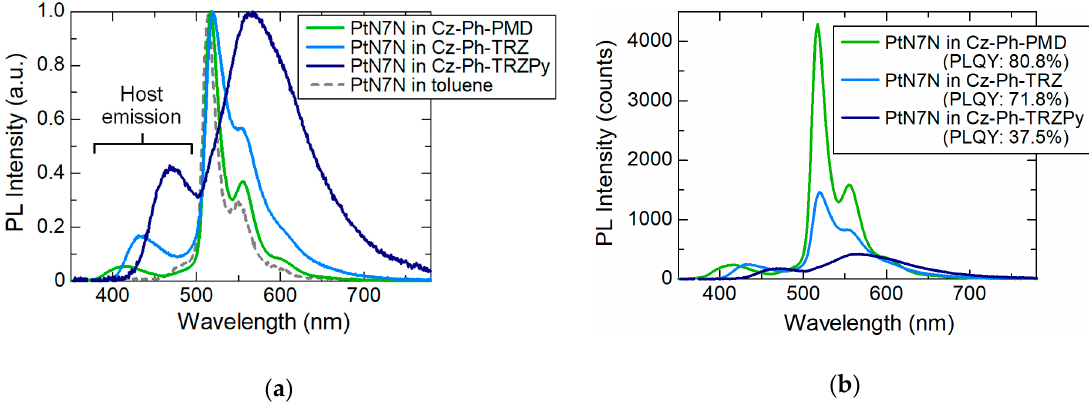
Figure 5. PL spectra of PtN7N in Cz-Ph-PMD, Cz-Ph-TRZ and Cz-Ph-TRZPy: ( a ) the normalized PL spectra and ( b ) the non-normalized PL spectra.